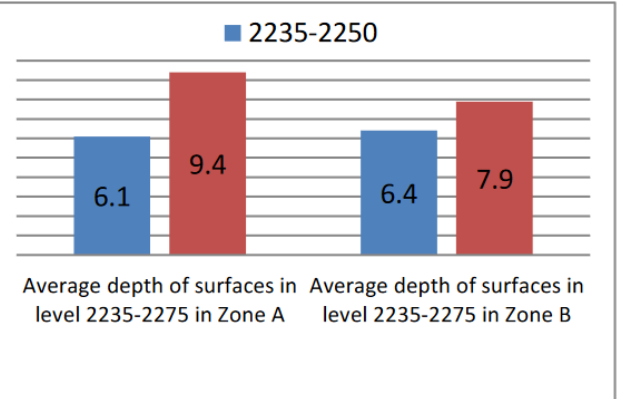
Figure 33. Average areas of semi-open spaces in Zone A and Zone B.